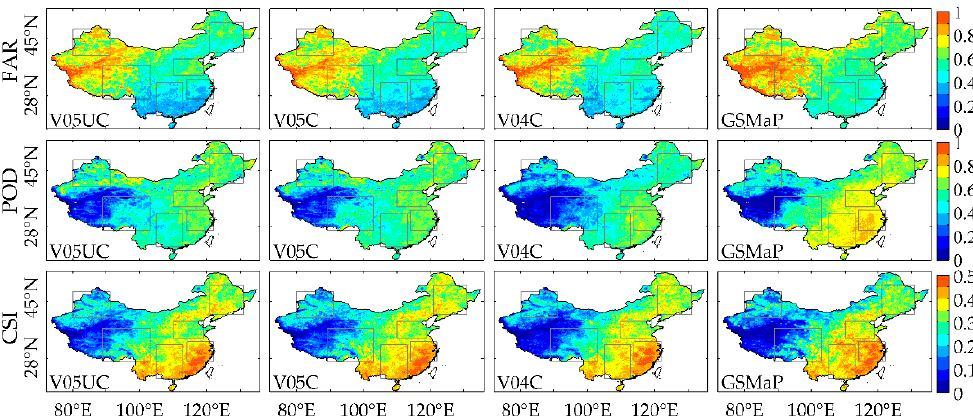
Figure 8. Spatial distributions of categorical statistical indices—false alarm ratio (FAR), probability of detection (POD), and critical success index (CSI)—of the four GSPEs—i.e., uncalibrated Integrated Multi-satellitE Retrievals for the GPM (IMERG) V05 (V05UC), gauge-calibrated IMERG V05 (VU05C), gauge-calibrated IMERG V04 (V04C), and Global Satellite Mapping of Precipitation (GSMaP)—for the entire study period from April 2014 to December 2016 at a 3-h and 0.1° × 0.1° resolution over mainland China.